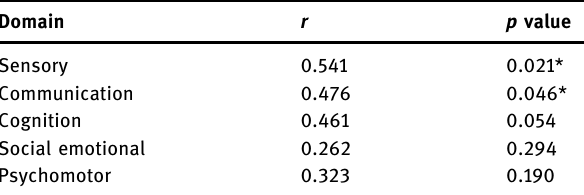
Table 8: Pearson correlations between the number of interactions with Kaspar and the change in domain scale scores